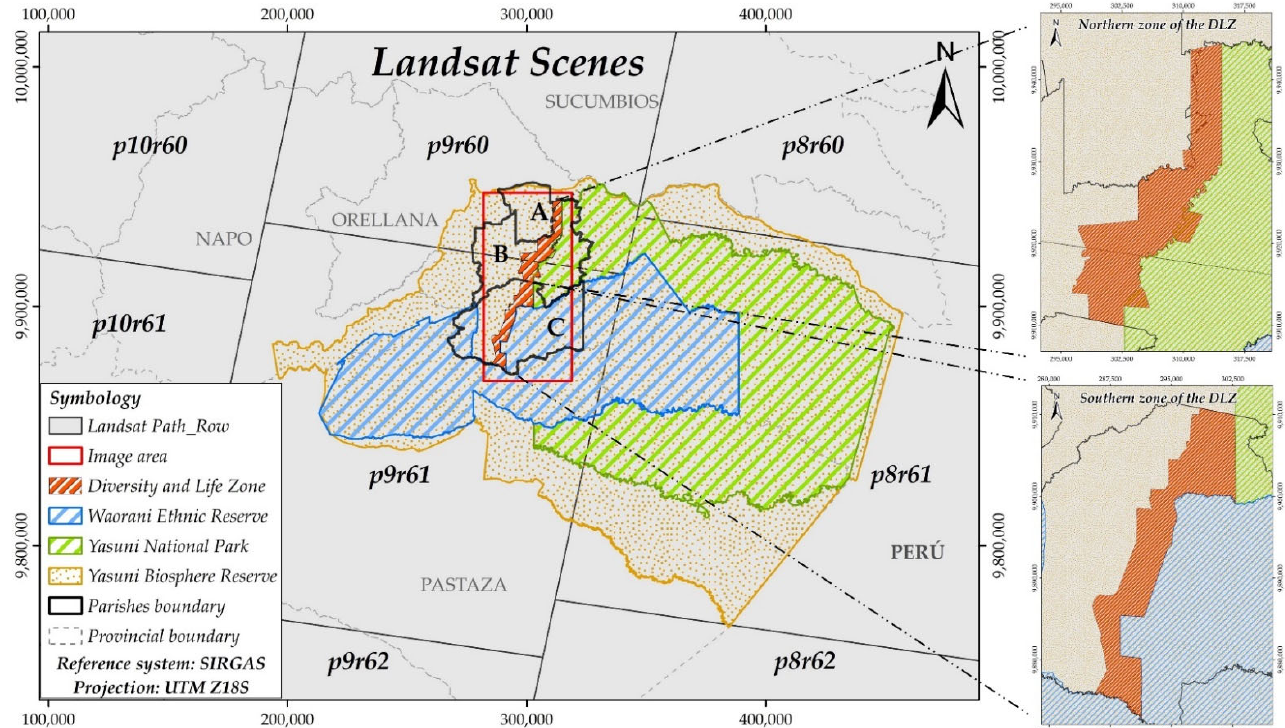
Figure 2. Footprint of the two satellite images (Landsat 5, 7, and 8) in the Zone of Diversity and Life of the Ecuadorian Amazon Region. Parish boundaries: ( A ) Taracoa, ( B ) Dayuma, and ( C ) Inés Arango .